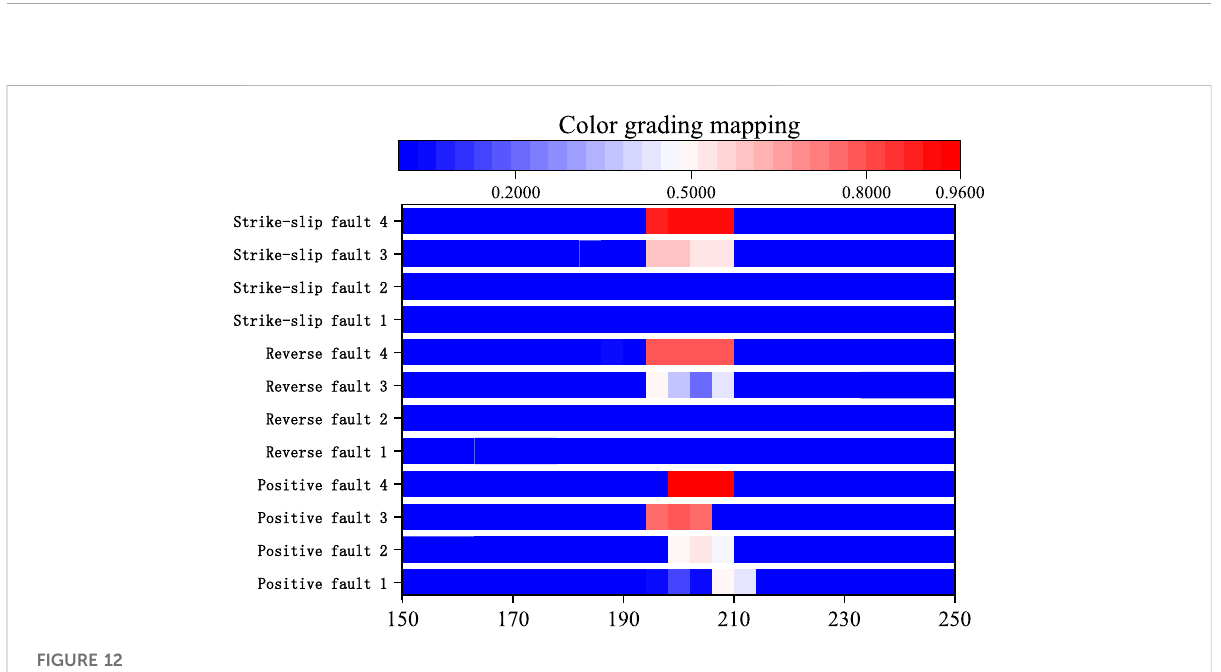
FIGURE 12 Damage proportion under various working